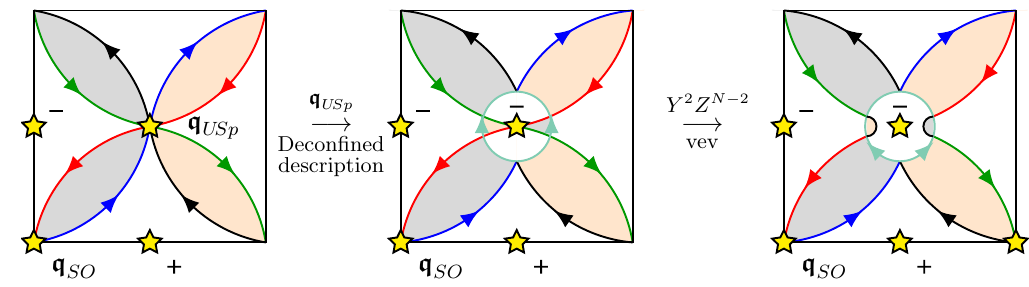
Figure 20. Deconfined description of q part of phase I . We have kept q confined in the tiling USp SO for clarity; deconfining it leads to an additional SU( N − 1) gauge factor that we have written explic- itly in (3.19). Turning on a vev for Y 2 Z N − 2 leads to recombination of the green and red NS5